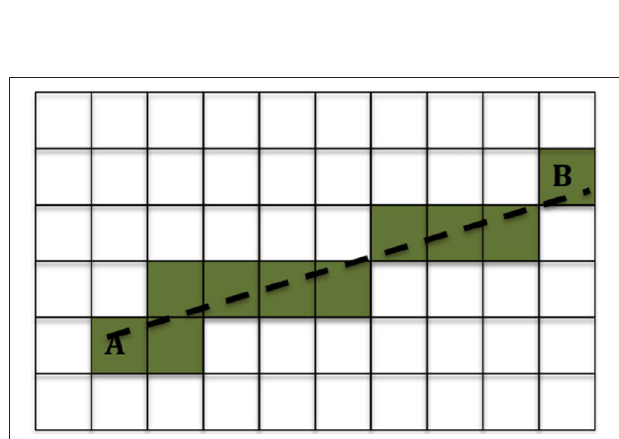
FIGURE 1 | Difference in covariances (DC), a measure of second order diffusion non-Gaussianity in brain tissue, for a coronal (left) , sagittal (middle) , and axial (right) slice in our data. The DC is plotted on a different scale in each slice. The higher the value of DC in a voxel, the stronger the diffusion non-Gaussianity in that voxel. We notice that the DC has large values predominantly in white matter areas of the brain.